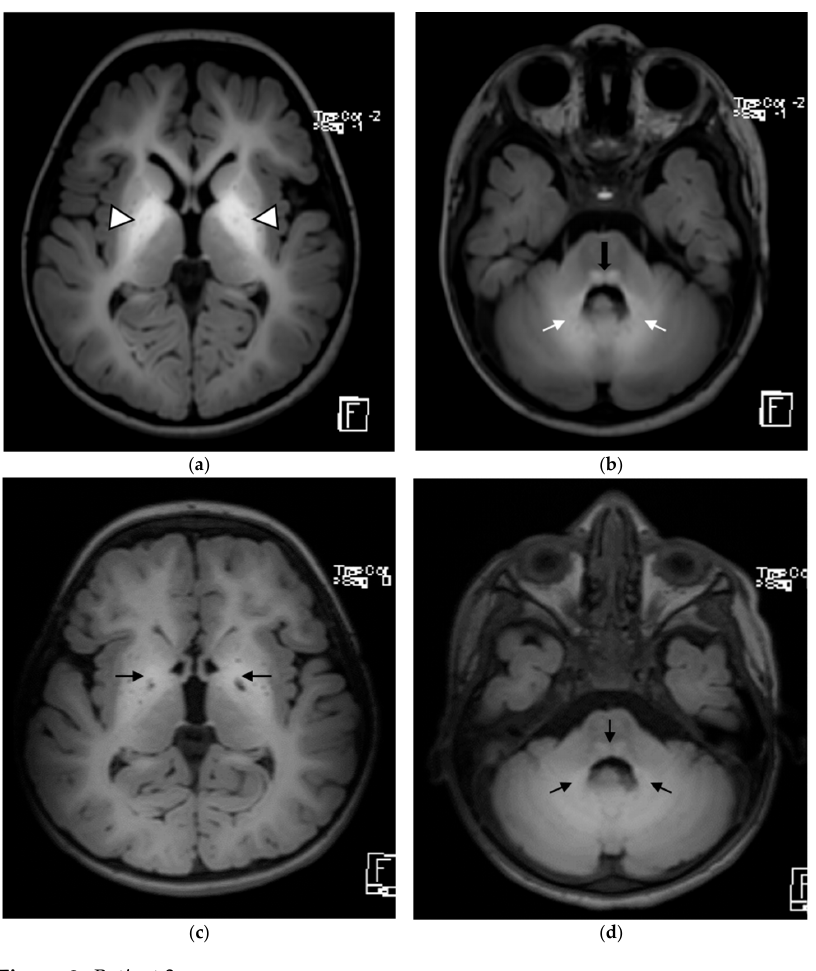
Figure 2. Patient 2